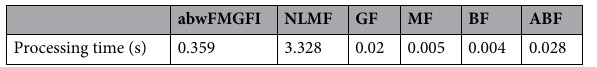
Table 16. Processing time of each filter.